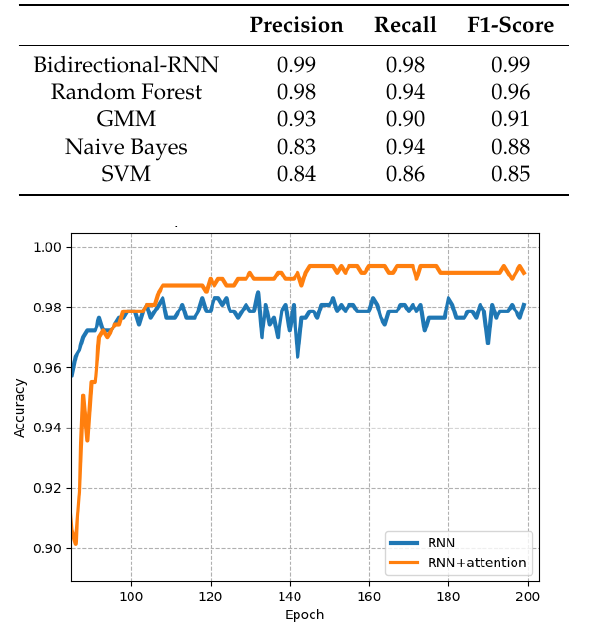
Figure 7. The accuracy comparison of RNN and RNN with Attention Mechanism.